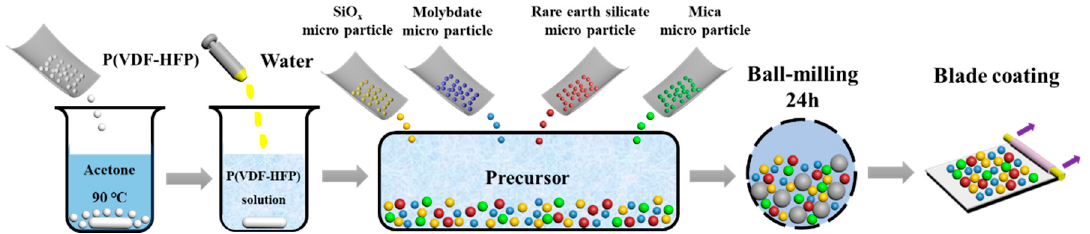
Figure 1. Schematic of the preparation process of the radiative cooling coating.